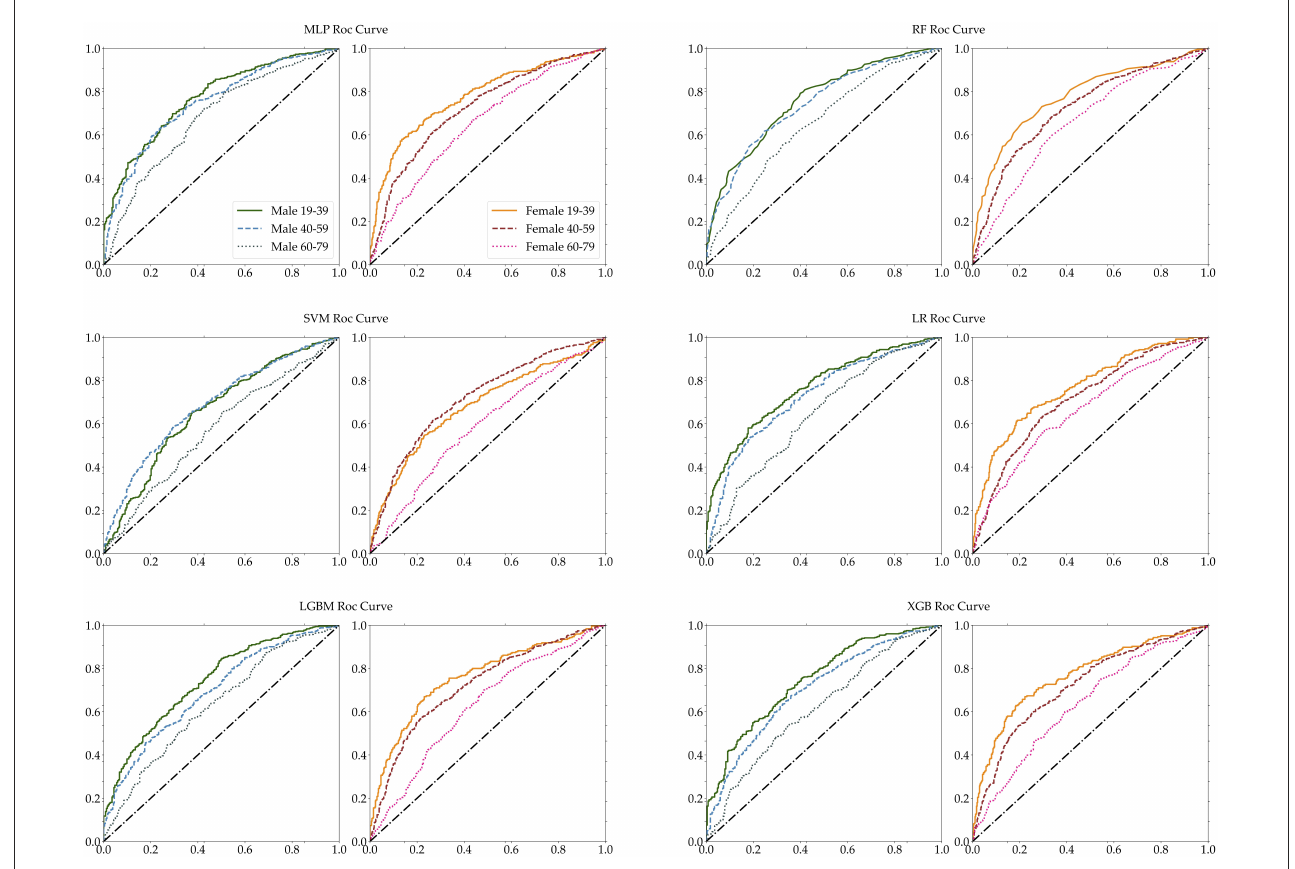
FIGURE5 Age-specific ROC curves for each MLP, RF, SVM, LR, LGBM, and XGB. The left panel of each pair is male, while the right panel is female.